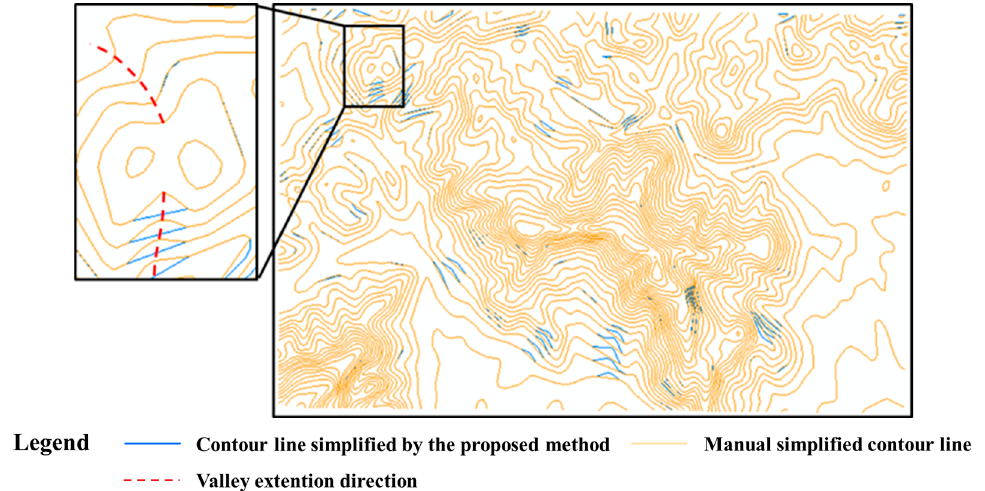
Figure 17. Results of the proposed method and those of manual simplification. In summary, the method proposed in this study effectively extracted valley lines and overcame the shortcomings of traditional methods regarding the identification of gradu- ally descending valleys. Our method successfully formed valley line networks with